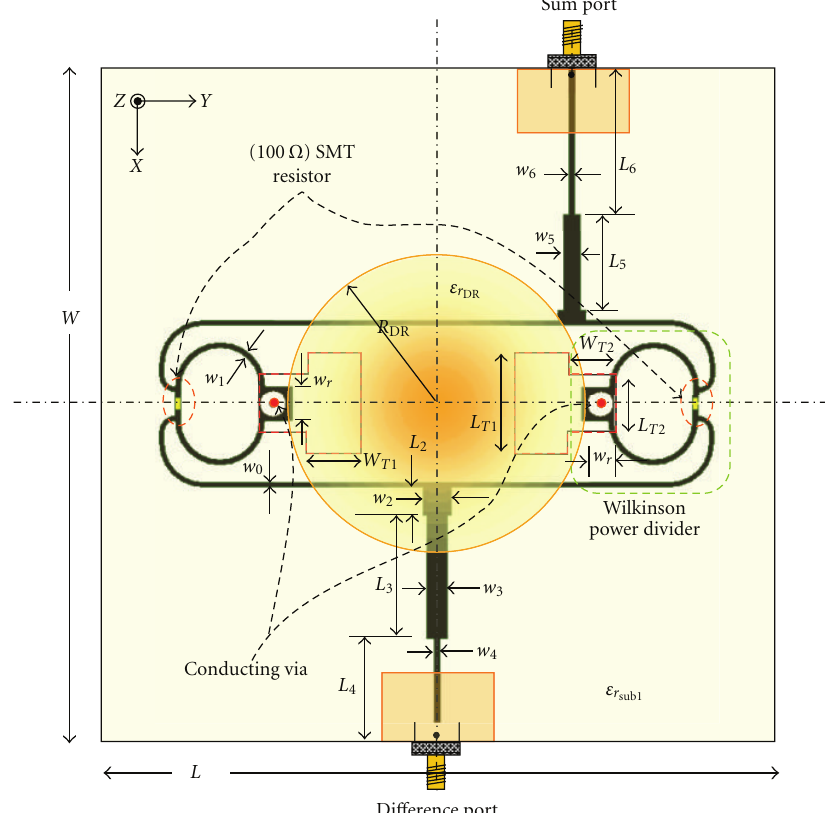
Figure 1: Top view of the proposed direction-finding geometry, where the bottom layer microstrip feeding network is shown in solid line.